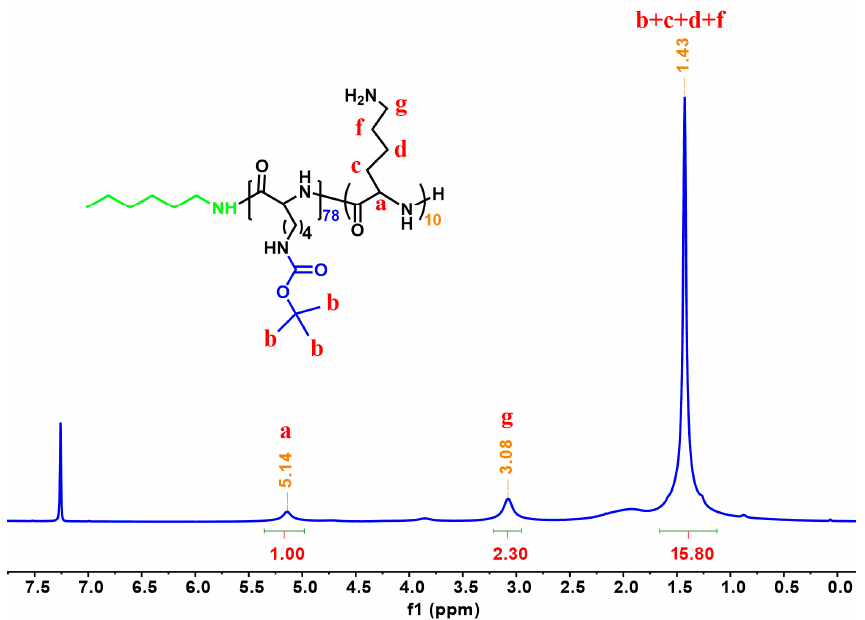
Figure 9. 1 H-NMR spectrum of partially deprotected PBLL 78 – b –PLL 10 copolymer. The polymer was further characterized by SEC, as shown in Figure 10.